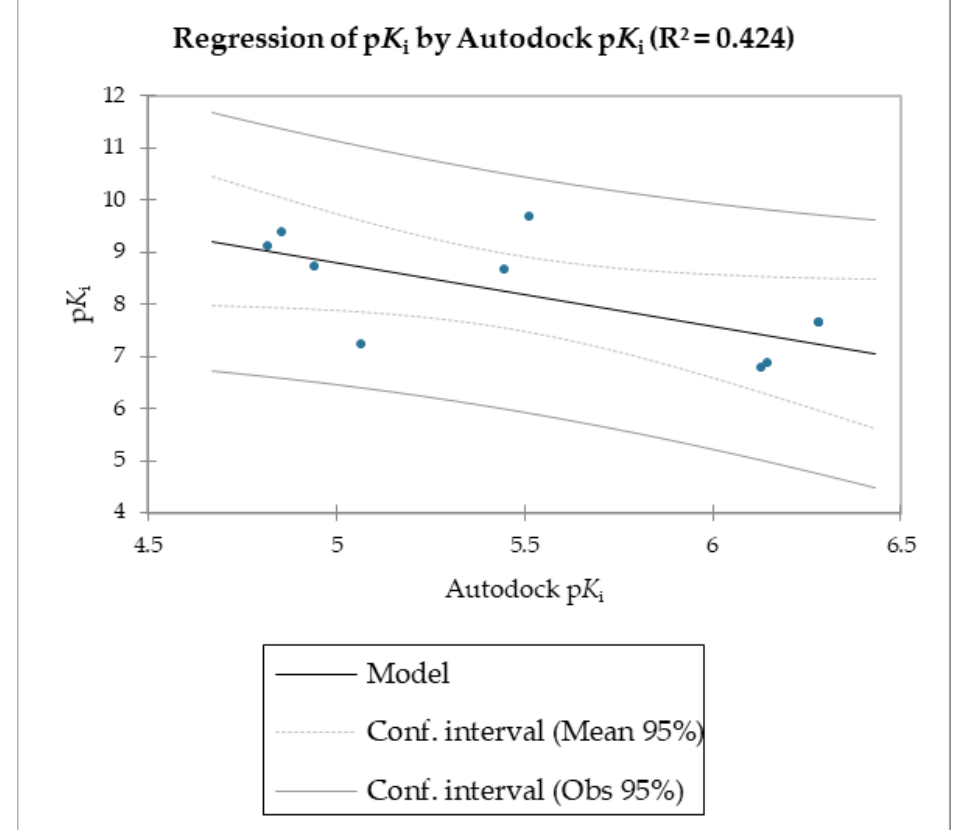
Figure 3. Regression of p K i with Autodock-calculated p K i . The reported data clearly shows the higher capability of SMD to score the affinities of small molecules against FABP4 compared to Autodock and Vina. In fact, as the value of the reference constant increased for each subset of molecules, we consistently obtained the increase of F max required to extract the ligand from its receptor, following a linear correlation. Conversely, the Autodock and Vina scoring functions were not as accurate as the SMD data in potency evaluation, as they showed poor correlation between the increased potency of the compounds and the calculated binding